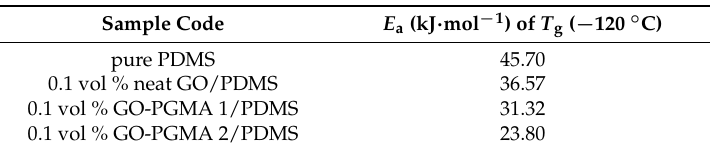
Table 1. Activation energies of a glass transition process for pure PDMS and PDMS composites with variously conducting particles.